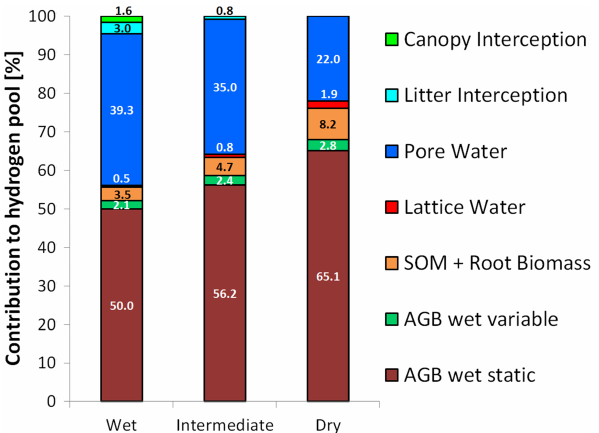
Figure 11. Varying hydrogen pools in the beech forest surround- ing the CRS for three different site conditions. AGB (aboveground biomass) wet variable represents hydrogen contained in deciduous leaves (both in the biomass and in the leaf water). AGB wet static comprises hydrogen contained in biomass and water of tree stems and branches as well as in biomass of the litter